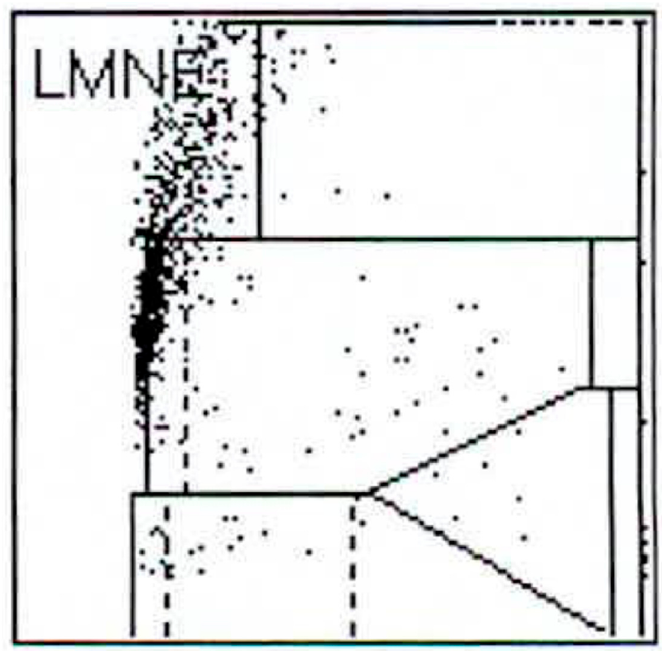
Figure 2. LMNE matrix of a type I (abrasion type) with a cloud in the NOISE-area of a 65-year-old male patient with an aspirate of the hip arthroplasty 15 years postoperative. The measured cell count was 1500 cells/ μ L.